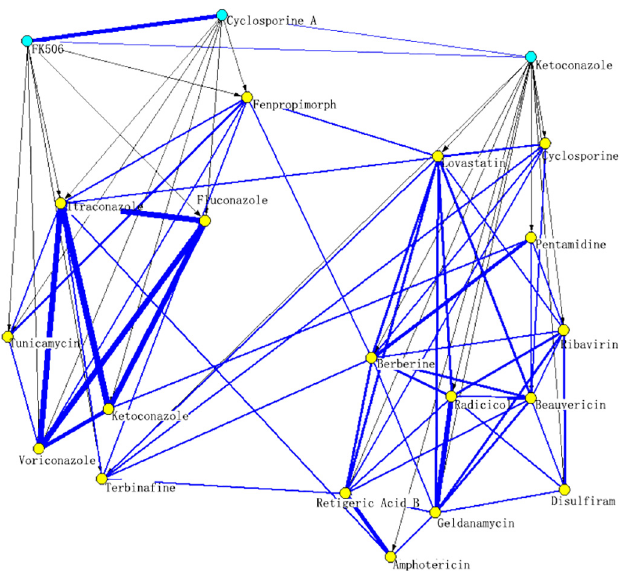
Fig 1. Schematic illustrating the similar nature of synergistic drug combinations. Blue nodes represent principal drugs, and yellow nodes represent adjuvant drugs. The arc from the principal drug to the adjuvant drug means that two drugs have synergistic effect when combined in the antifungal assays. The edge between two principal (adjuvant) drugs represents the similarity between two drugs. Thickness of edges linking drugs indicates degree of similarity between them. This figure shows adjuvant drugs which obtain synergistic effect with similar principal drugs are often similar. Similar principal drugs, Cyclosporine A and FK 506 gain synergistic effect with seven adjuvant drugs, including Fenpropimorph, Fluconazole, Itraconazole, Ketoconazole, Tunicamycin, Voriconazole, and Terbinafine. It can be observed that those seven adjuvant drugs are similar. Also the adjuvant drugs which obtain synergistic effect with Ketoconazole are similar and form a module. On the contrary, most of the adjuvant drugs which obtain synergistic effect with dissimilar principal drugs (Cyclosporine A and Ketoconazole, FK506 and Ketoconazole) are